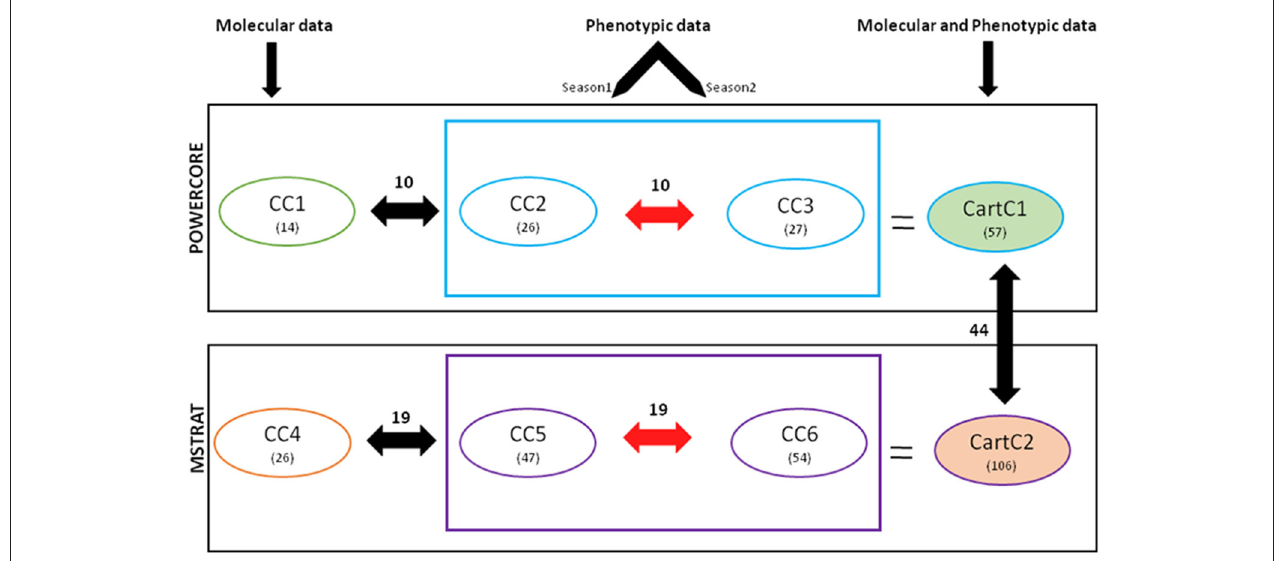
FIGURE 3 | Flowchart describing the strategy and results of development of core collection for safflower. Numerical values in parenthesis indicate the number of accessions in respective cores. Values indicated above the double-headed arrows depict the number of accessions common between different core collections.